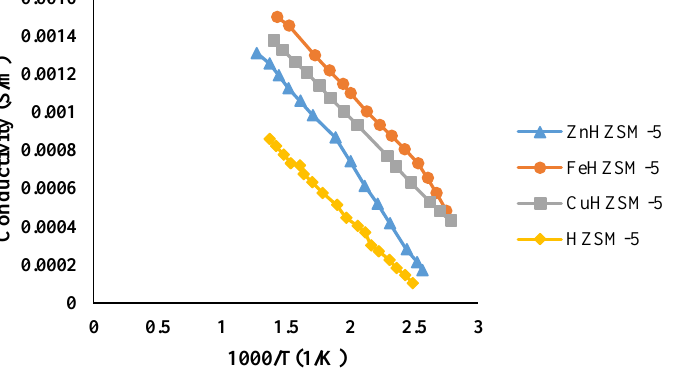
Figure 11. Electrical conductivity for HZSM-5, 4 wt. % FeHZSM-5, 4 wt. % CuHZSM-5 and 4 wt. % ZnHZSM-5 catalysts.